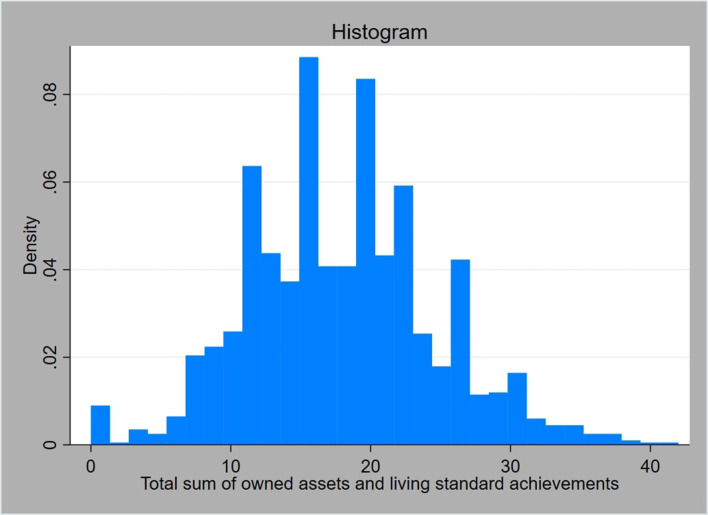
Household assets/living standards.